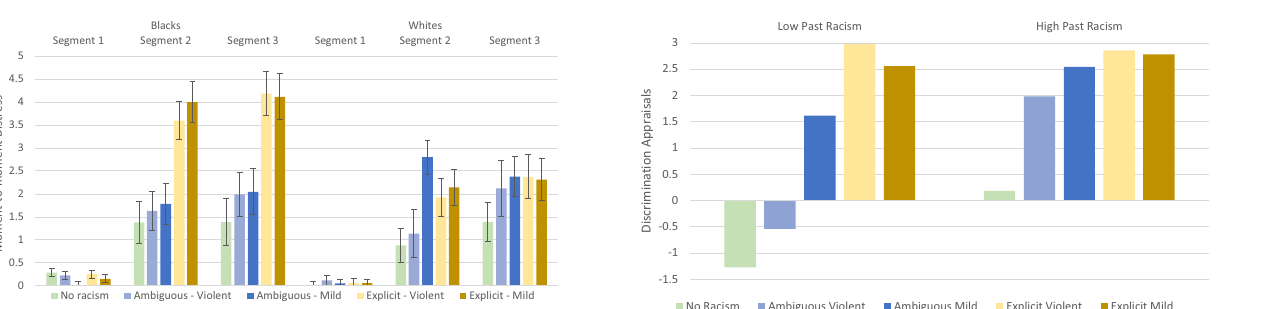
(Fig. 4), greater distress was expressed in response to explicit racism, irrespective of whether the events included violence, t (93) = 3.71, p < 0.001. An ANOVA on ratings of anger taken at the end of the videos indicated that, overall, Blacks expressed greater anger ( M = 2.67,